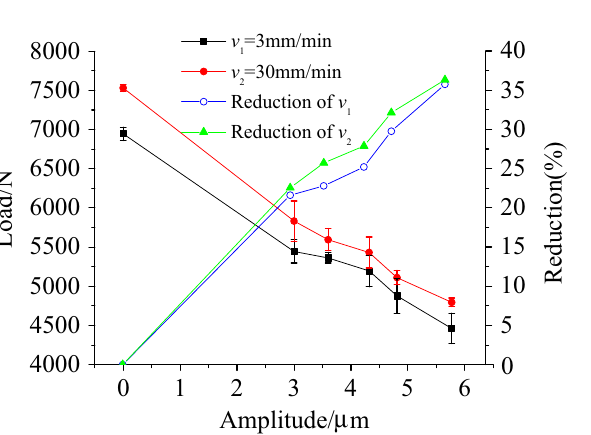
Figure 5. The variation of maximum riveting load and load drop with amplitude under different riveting